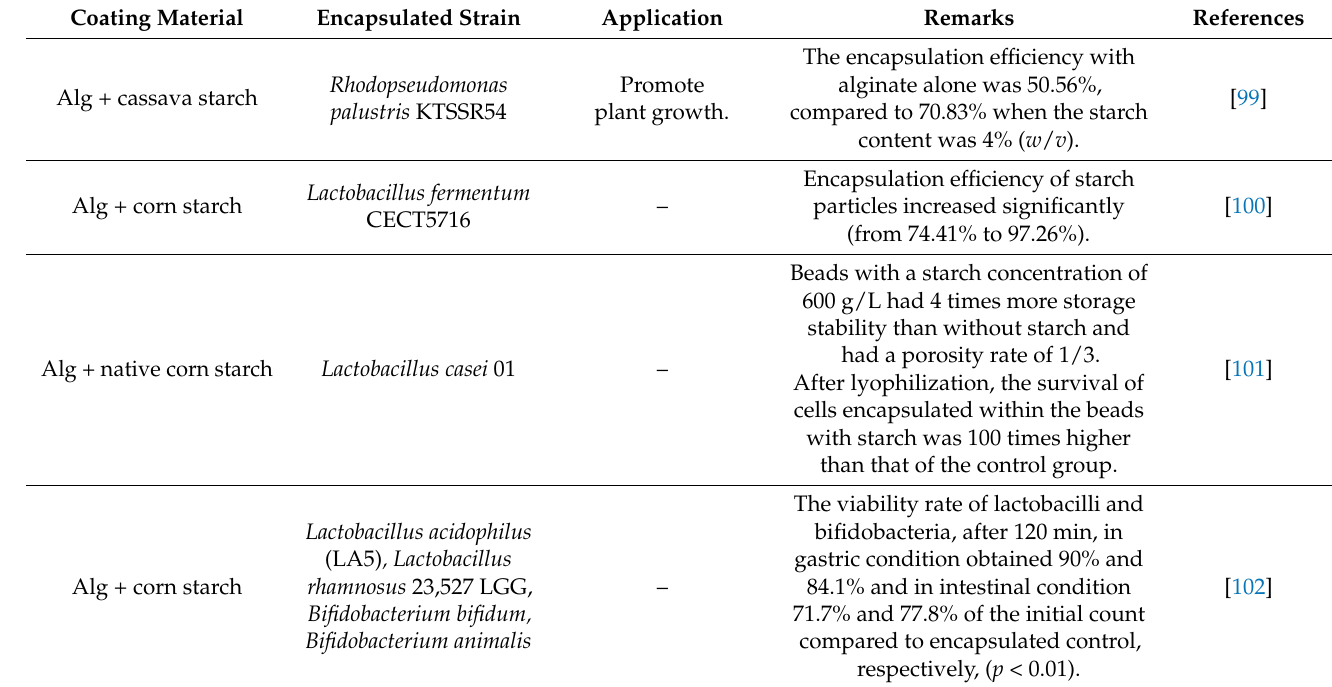
Table 3. Microencapsulation of probiotics with physically modified